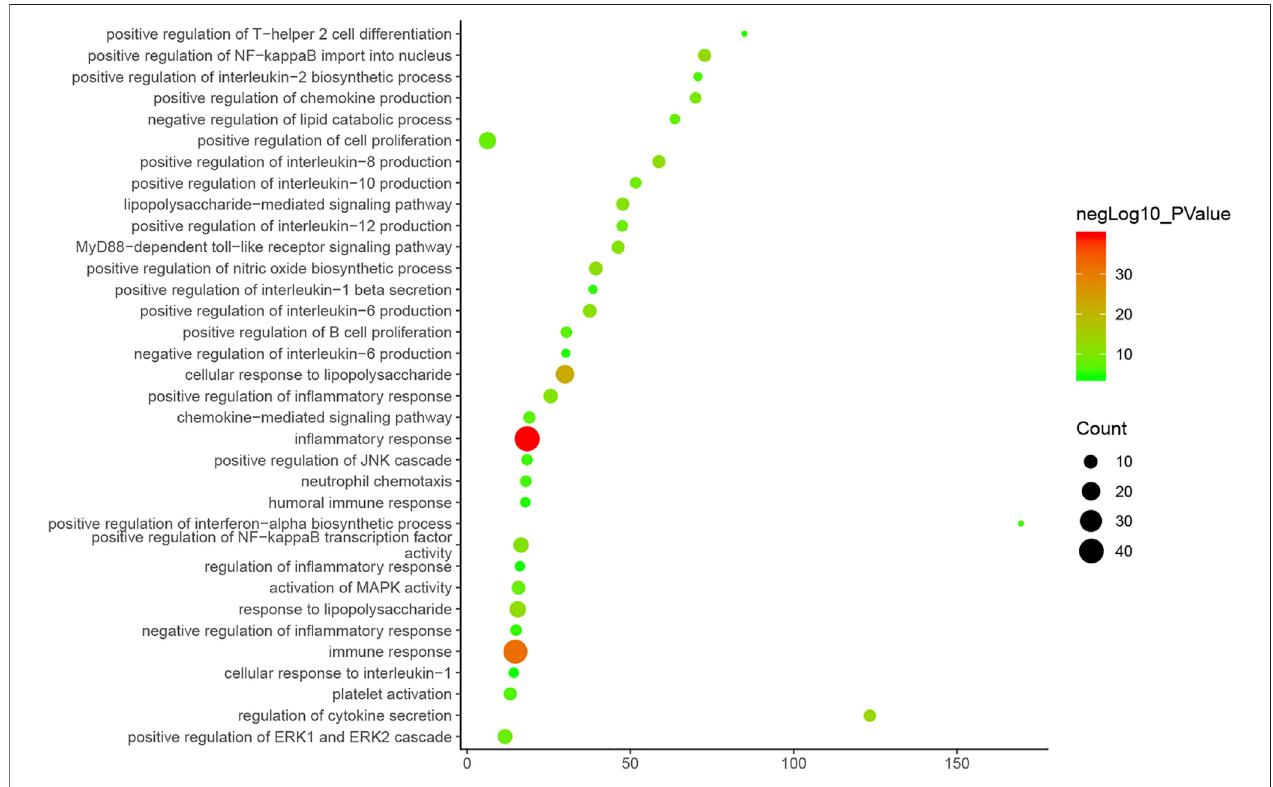
FIGURE 5 | Bubble chart of biological processes in cluster 1 (X-axis stand for fold enrichment).